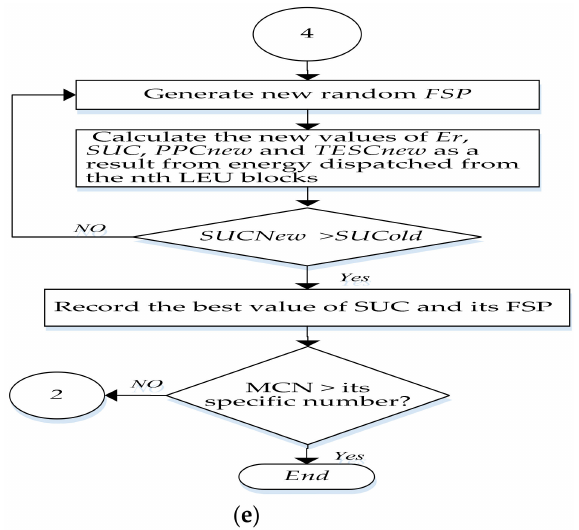
Figure 4. The methodology of the modified artificial bee colony with a new searching mechanism (MABC-NSM) algorithm: ( a ) Initial bee colony (Icol); ( b ) NSM-Employed bee colony ( Ecol ); ( c ) and ( d ) → ← k ∗∗∗ and k ∗∗∗ respectively; ( e ) Scout bee colony NSM-Onlooker bee colony ( Ocol ) for